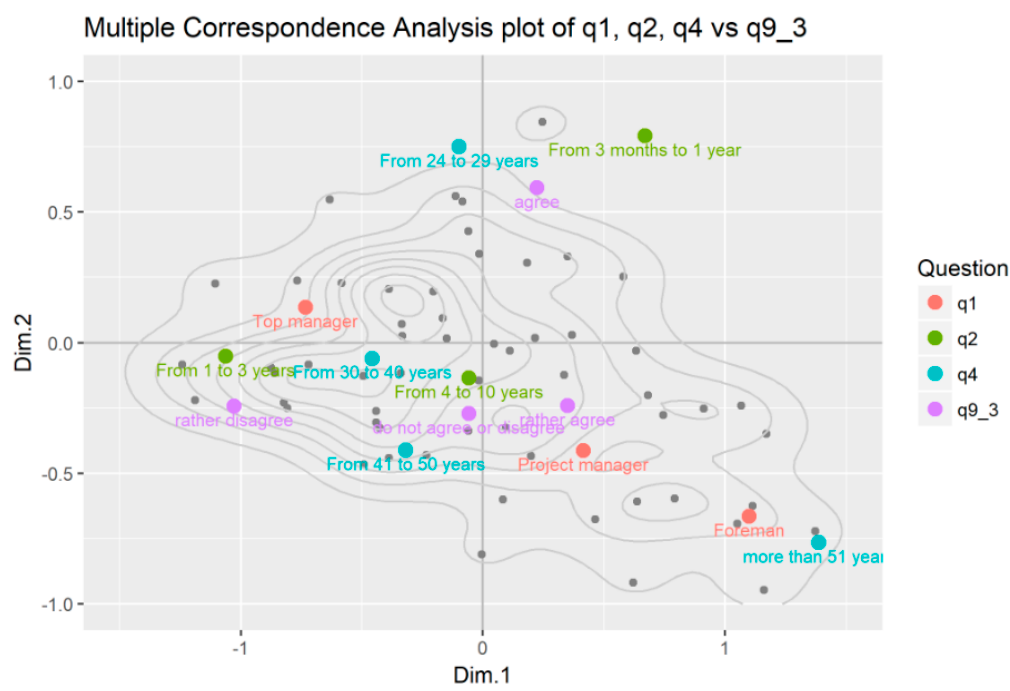
Figure 2. Answers to the question: I have skills and abilities that are not used in my work.